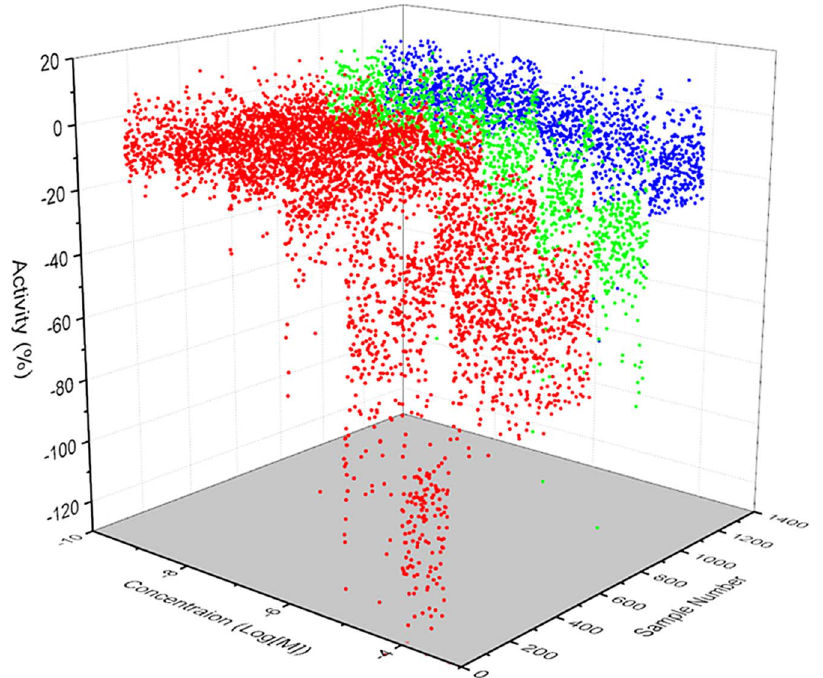
Figure 2. Confirmation Assay Molecules. A 3-axis plot of the 1356 compounds identified in the confirmation assay is shown. Compounds are sorted by curve class. Red: active compounds in curve class 1 and 2. Green: weakly active compounds in curve class 3. Blue: inactive compounds in curve class 4.